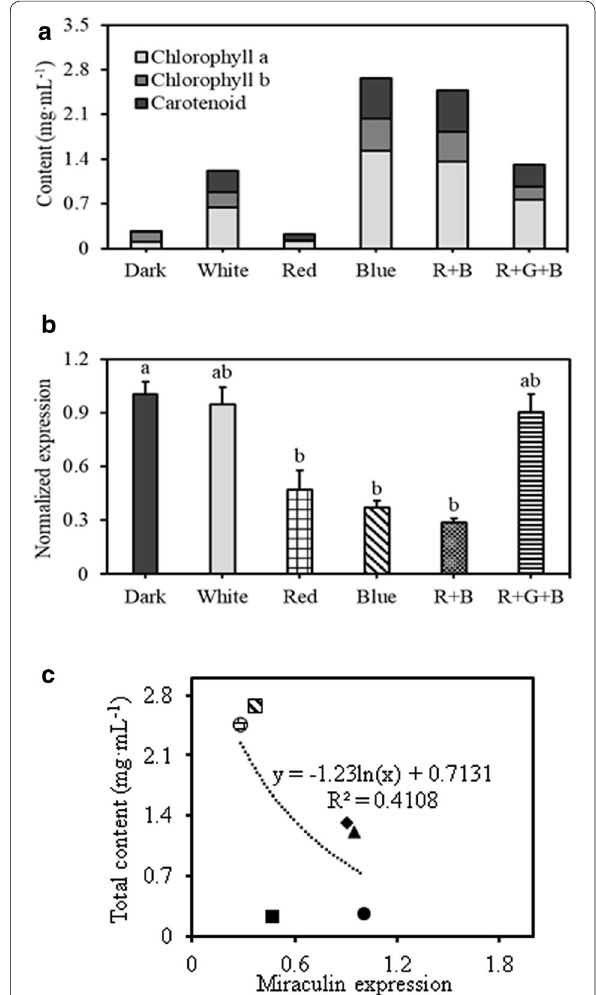
Fig. 3 The relation between chlorophyll content and miraculin expression from transgenic carrot callus cultured under different light qualities. a Chlorophyll and carotenoid contents of transgenic callus; b Miraculin expression in transgenic callus; c Correlation analysis of chlorophyll, carotenoid with miraculin expression. Transgenic callus grown in the dark served as a control. Data represent mean ( n 5). The value of control was taken as 1 to compare with = transformed callus line. Different lowercase letters indicate statistically significant differences ( P < 0.05; Duncan’s multiple range test)